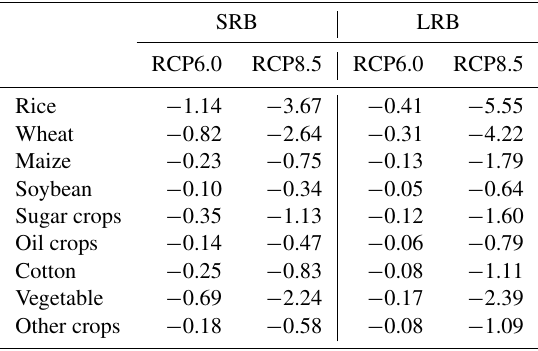
Table 3. Percent change in yield under two climate scenarios au- tonomous adaptation in 2030 (compared with the reference sce- nario, %).